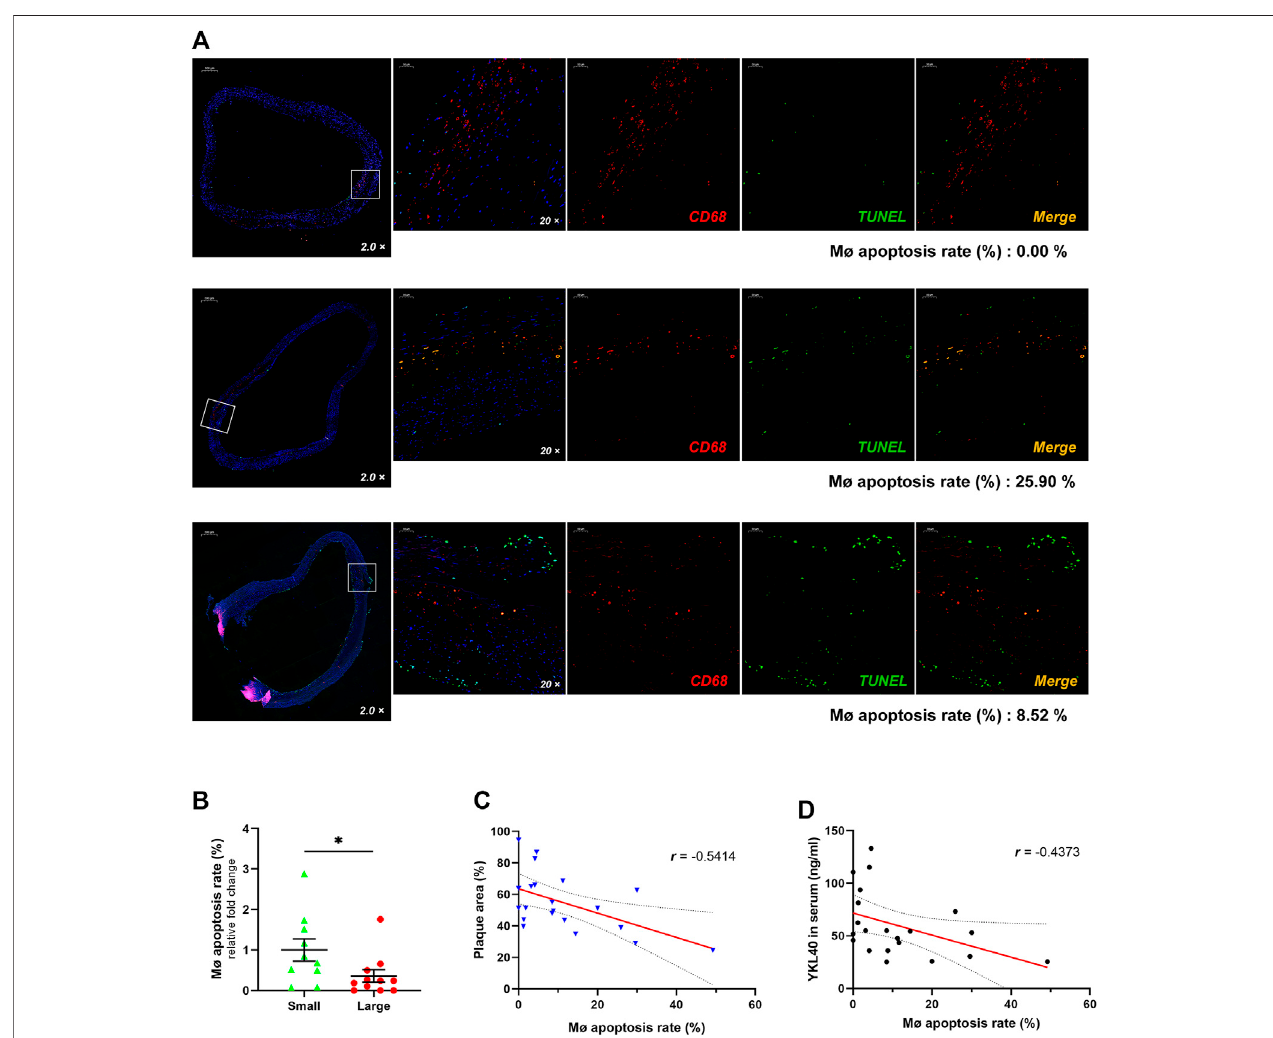
FIGURE2|(A) Theimmuno fl uorescentdouble-labelledstainingforcarotid plaque samples.CD68 + waspresenting asred fl uorescence while TUNEL + isshown as green and Merge as golden. The proportion of TUNEL + in CD68 + cells was calculated as the apoptosis rate of macrophages, which is shown beneath each panel. (B) The macrophage apoptosis rate in the large group was signi fi cantly lower than that in the small group ( p (cid:1) 0.0497). (C) There was a signi fi cant negative correlation between the macrophage apoptosis rate and relative plaque area ( r (cid:1) − 0.5414, p (cid:1) 0.0112). (D) There was a signi fi cant negative correlation showed between the macrophage apoptosis rate and expression level of YKL-40 in serum ( r (cid:1) − 0.4373, p (cid:1) 0.0475).